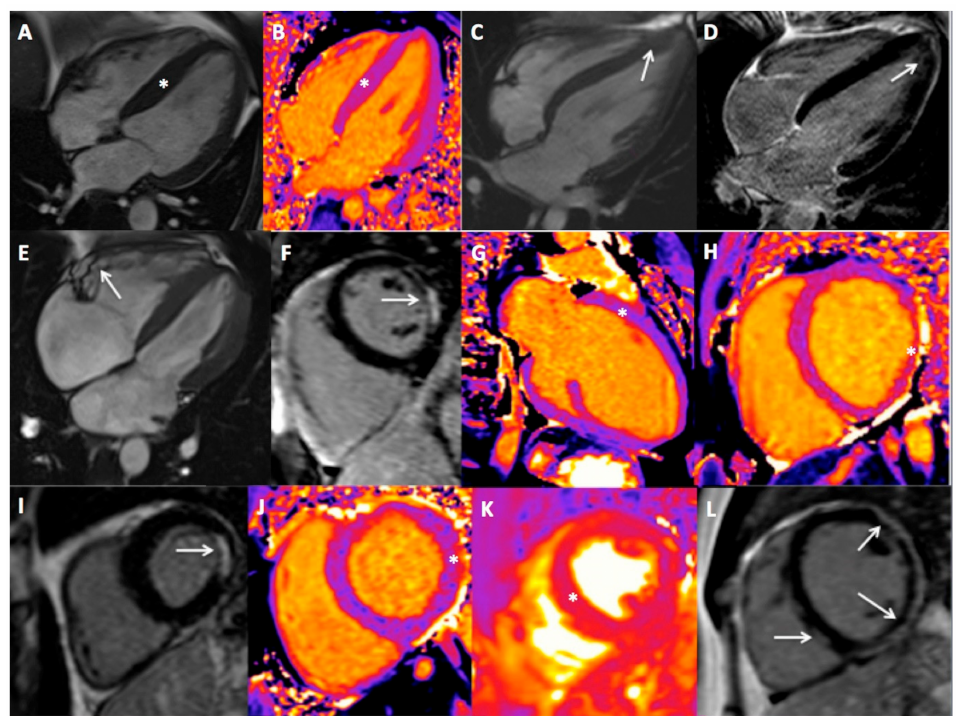
Figure 1. Examples of main cardiac magnetic resonance findings in the studied group. ( A ) 4-chamber cine view in an amateur triathlete with hypertrophic cardiomyopathy (HCM, asterisk), ( B ) 4-chamber T1-mapping view in an amateur footballer with HCM and visible increase of T1 time in the inter- ventricular septum (asterisk), ( C , D ) 4-chamber cine and LGE views in an professional footballer with apical HCM (arrow, C) and small areas of LGE (arrow, D), ( E , F ) 4-chamber cine and short axis LGE views in a semi-professional triathlete showing unbalanced enlargement of the right ventricle with areas of dyskinesia (arrow, E) accompanied by non-ischemic LGE in the left ventricle (arrow, F), ( G ) 2-chamber T1-mapping view in a professional footballer with dilated cardiomyopathy (DCM) and elevated T1 time (asterisk), ( H ) Short-axis T1-mapping view in an amateur runner with DCM and elevated T1-time (asterisk), ( I ) Short axis LGE view in an amateur veteran runner showing small ischemic scar post silent myocardial infarction (arrow), ( J , K ) Short axis T1-mapping and T2-mapping views in a professional volleyball player with acute myocarditis (elevated T1 and T2 time shown with asterisks), ( L ) Short axis LGE view in an amateur runner with prior myocarditis and extensive sub-epicardial LGE in the lateral wall and mid-wall LGE in the inter-ventricular septum